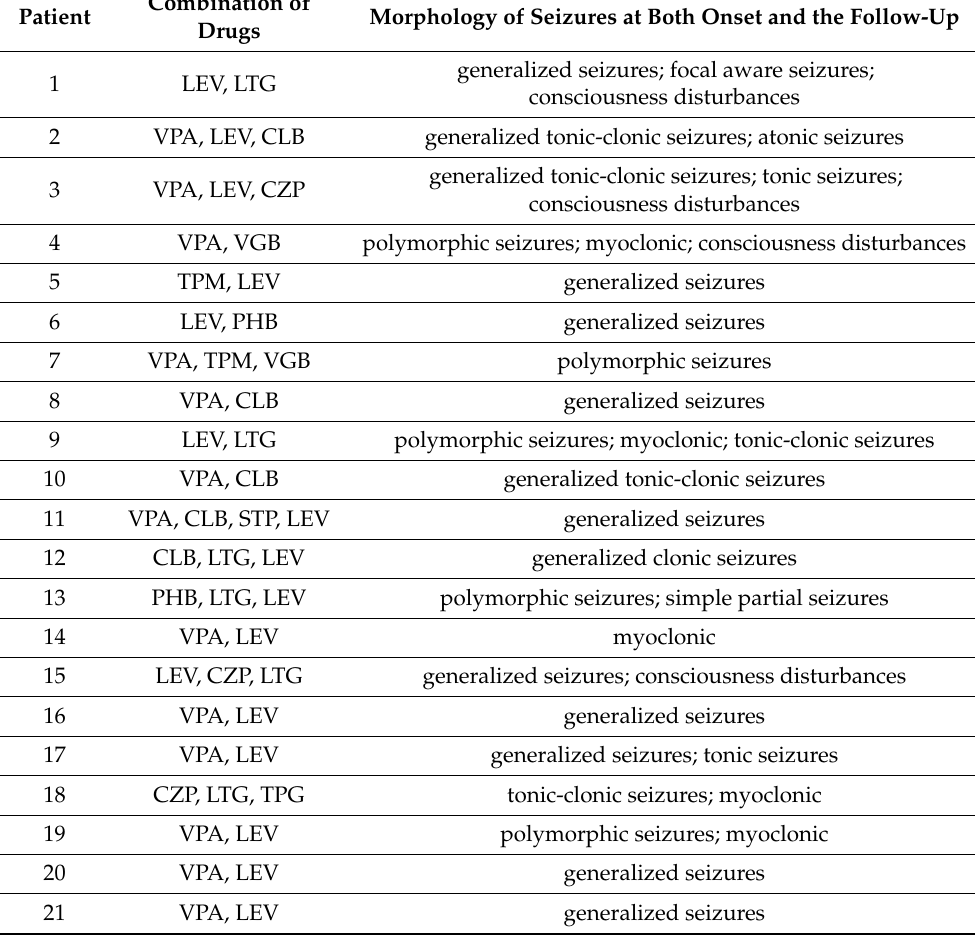
Table 1. Combination of AEDs and morphology of seizures at both onset and follow-up in analyzed epileptic